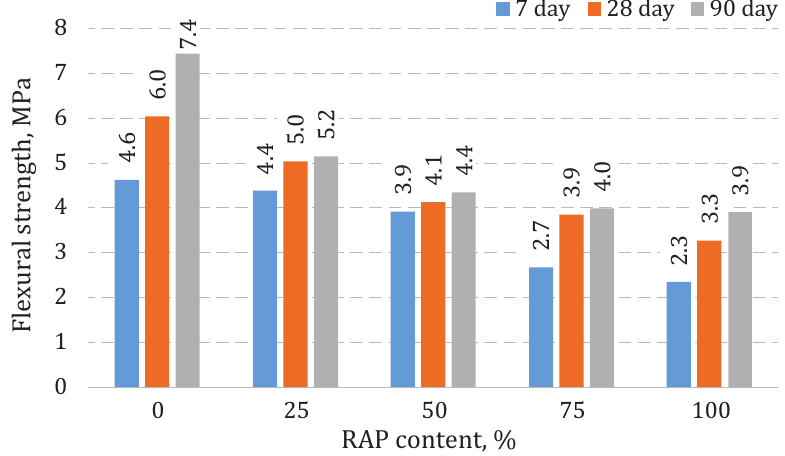
Figure 8. Flexural strength of the mixtures containing RAP at different